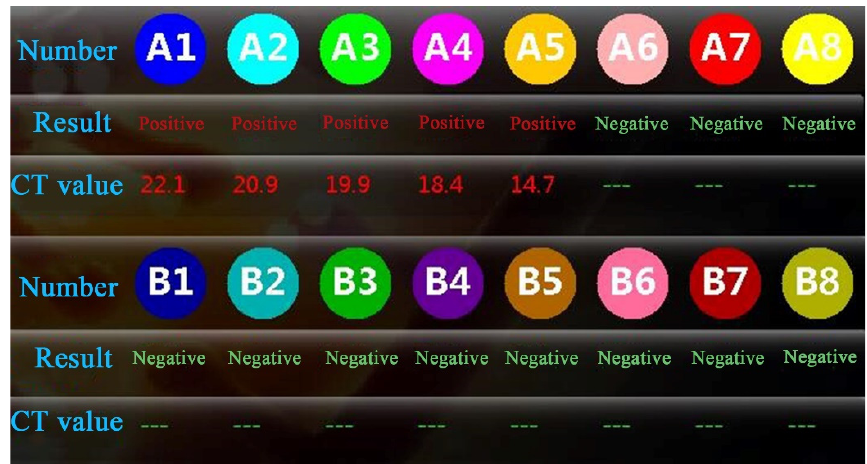
Figure 7. The results of DNA detection of single nematodes by EMA. The corresponding test samples of wells A1–A4 are J 2 , J 3 , and J 4 juveniles and adults, respectively. Sample A5 was the positive control, whereas A6 was the negative control. A7, A8 and B1–B8 are empty slots.